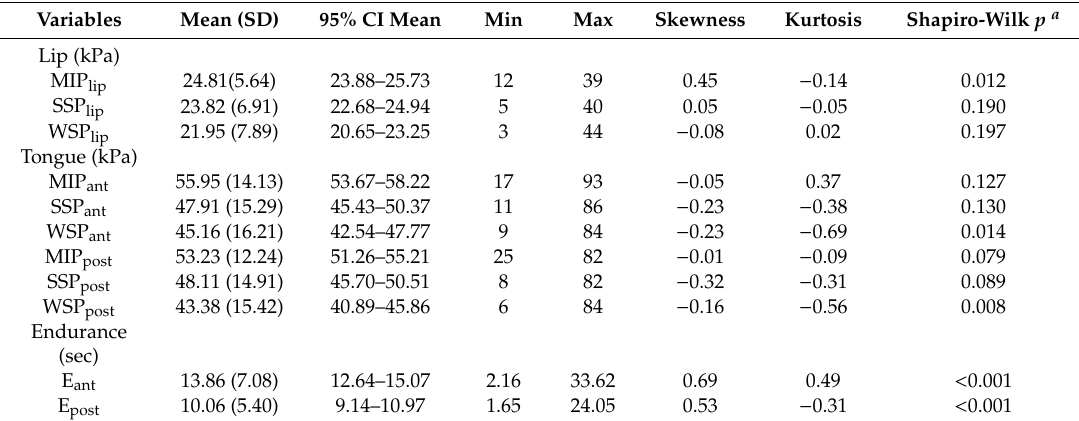
Table 3. The normality test of variables without outliers.